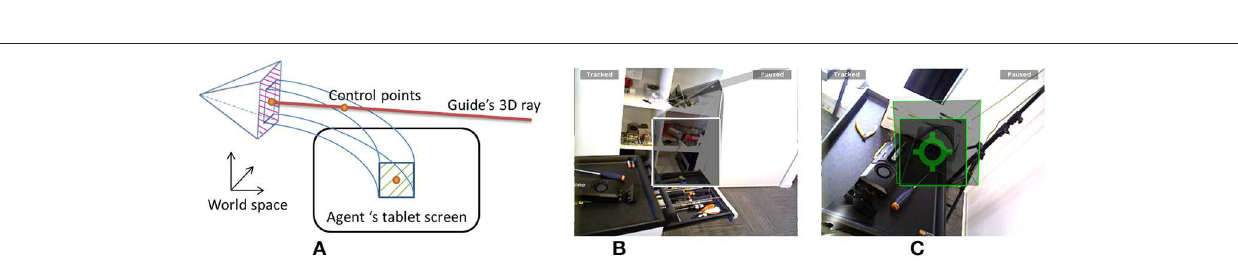
FIGURE 13 | The back of our AR tablet prototype. The Google Tango tablet uses sensor fusion with a fish eye camera and IMU to provide a SLAM-based six-DoF tracking. The RGB-D camera is a Asus Xtion powered with USB. These two devices are mounted using a 3D printed support on a Microsoft Surface Pro 3 (Intel CoreI7 with HD Graphics 5000 chipset) which provides processing resources as well as a large display.